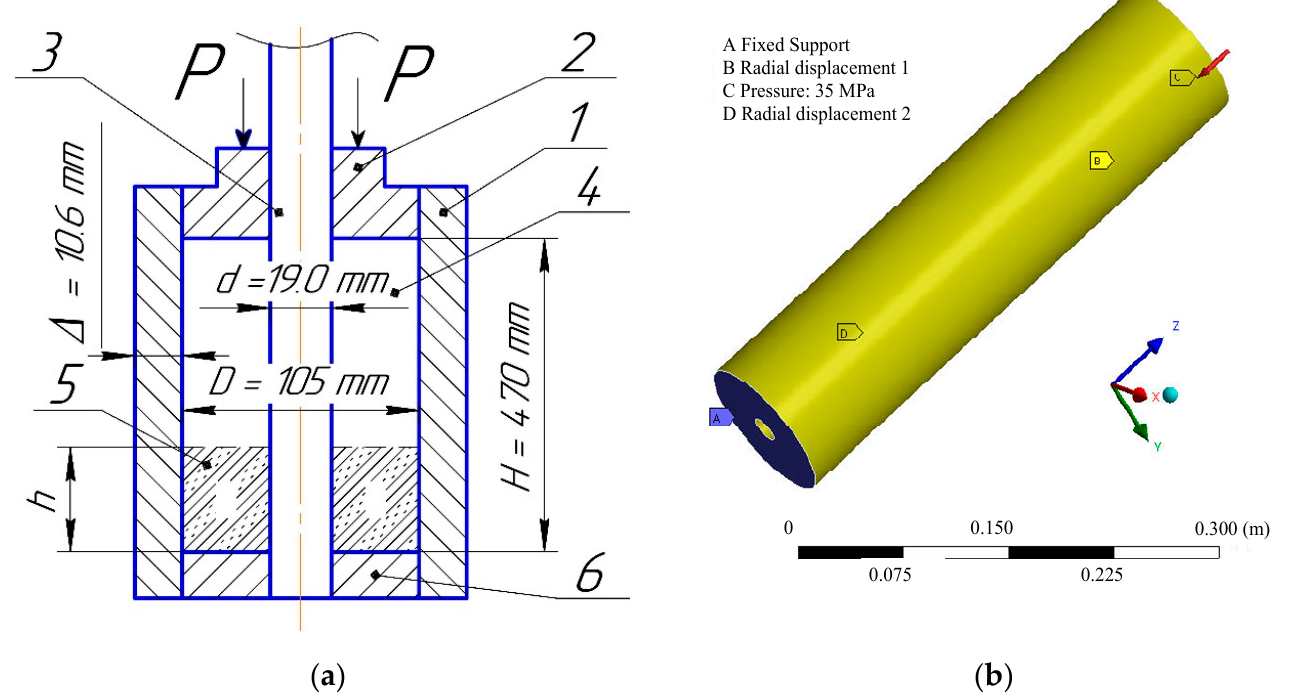
Figure 9. Macromechanical scheme of composite materials during compression pressing: 1 – matrix; 2, 6 – upper and lower punches; 3 – mandrel; 4 – powder weight; 5 – compressed tablet: experimental setup ( a ); solid-state simulation model ( b ).